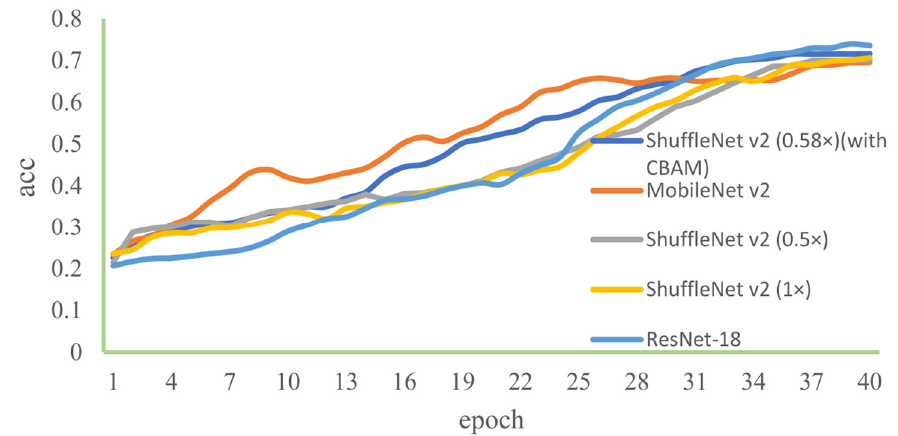
Figure 12. Comparison of the accuracy on different models.